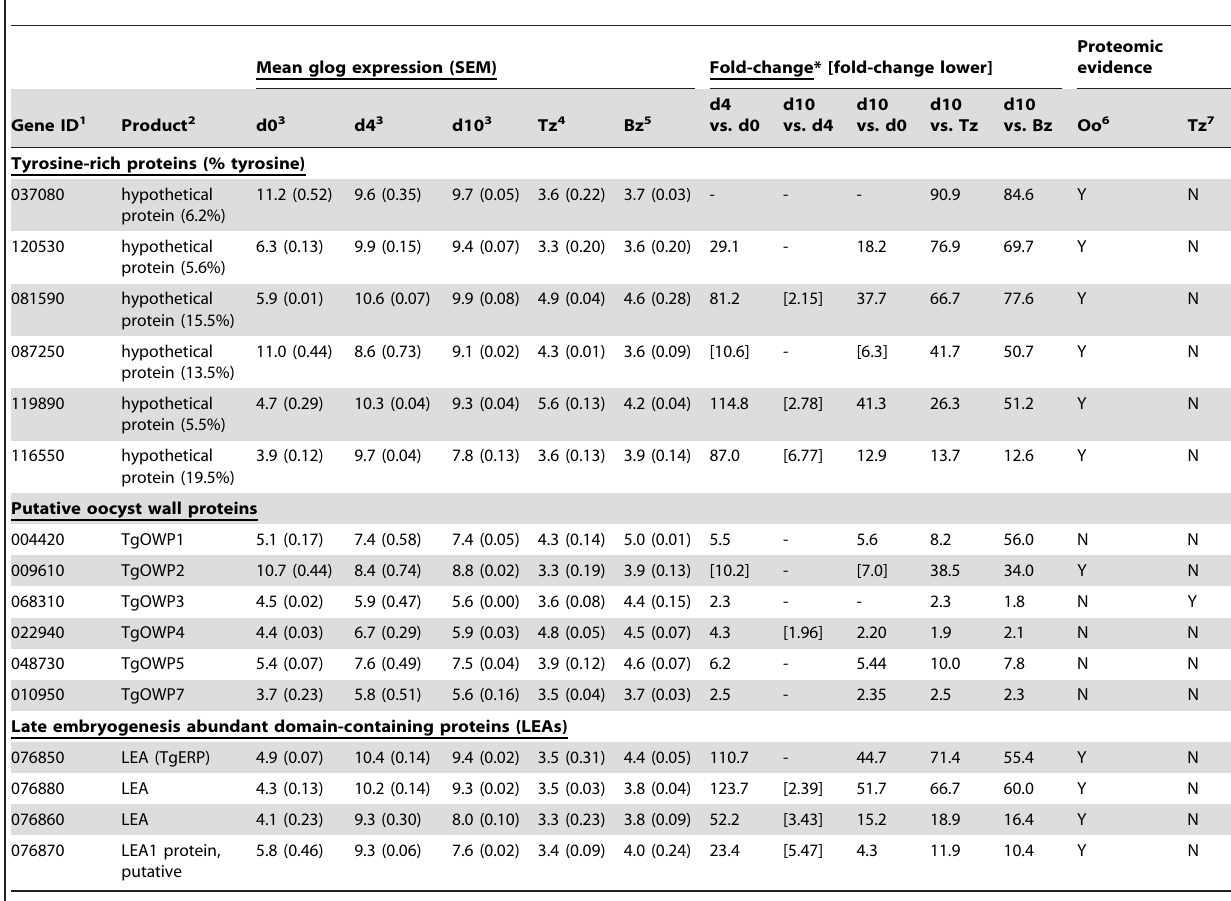
Table 8. Functionally interesting genes of Toxoplasma gondii oocysts at different stages of maturation with a comparison to bradyzoite and tachyzoite expression levels - other proteins of